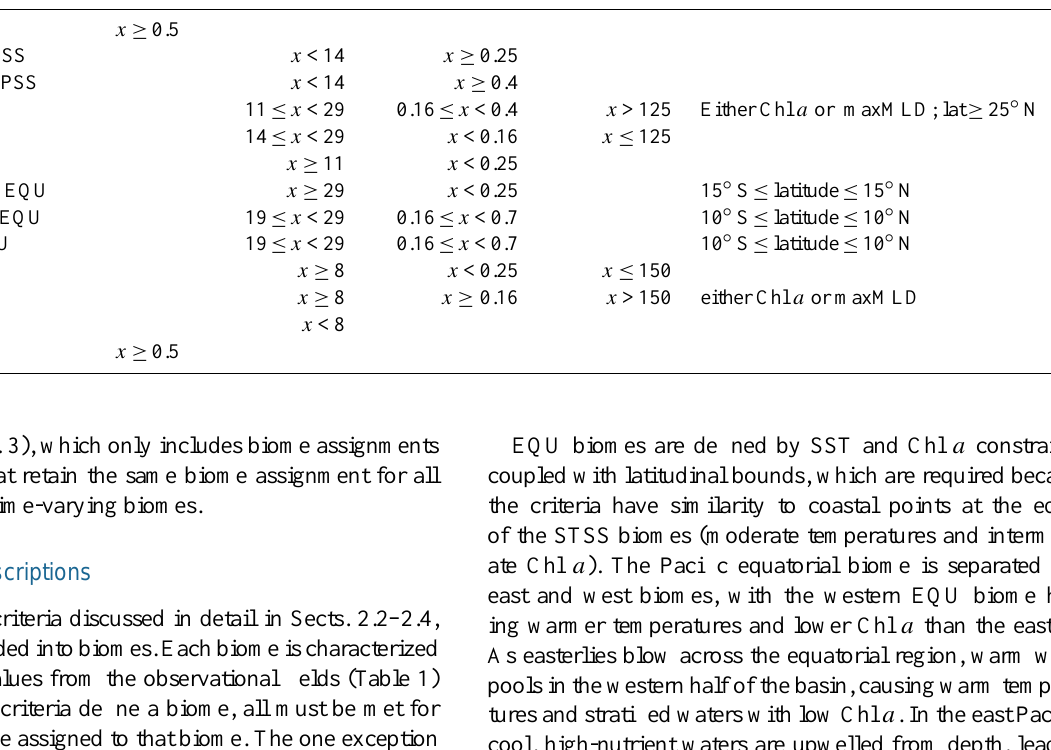
Table 1. Characteristics for the environmental envelopes defined for each biome. All criteria must be met for the biome to be assigned except where otherwise noted (STSS biomes). Chlorophyll is based on summer chlorophyll values.